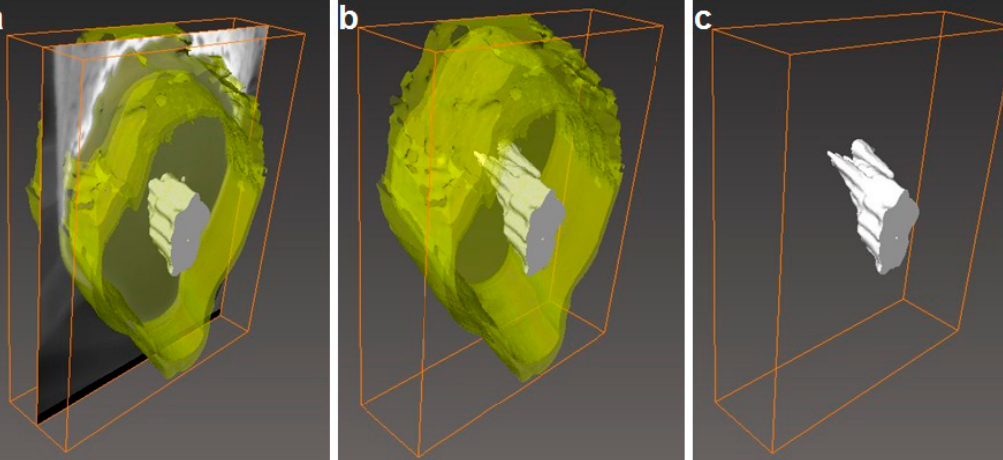
Figure 8. The cross-sectional SEM image of two PHB fibers with Pd nanoparticles after FIB sectioning.